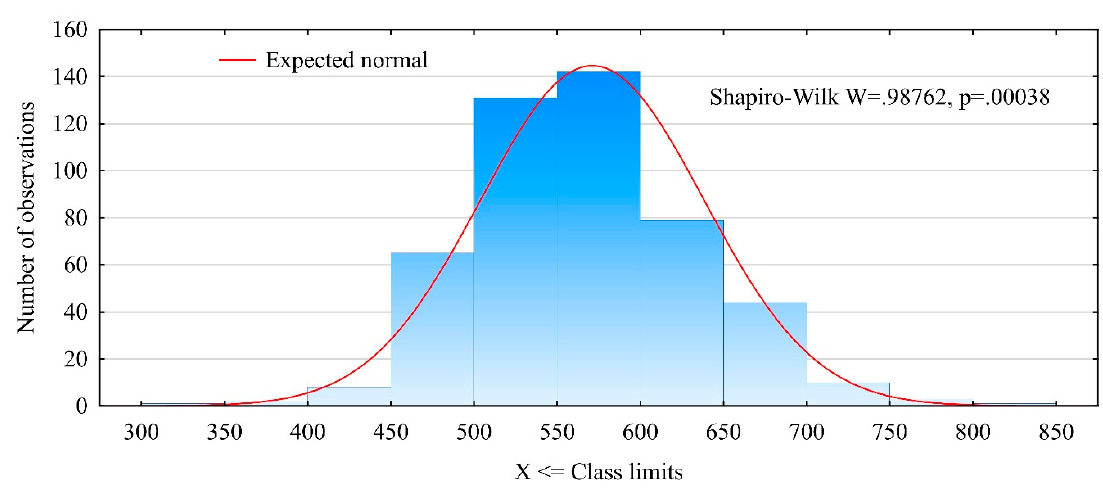
Figure 4. Density distribution for the timber.